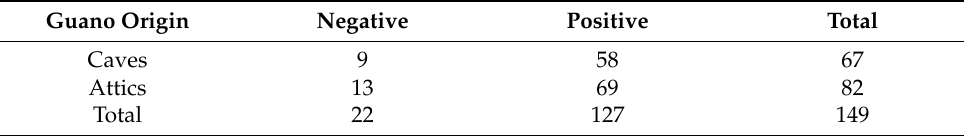
Table interpretation. qPCR = quantitative PCR test.